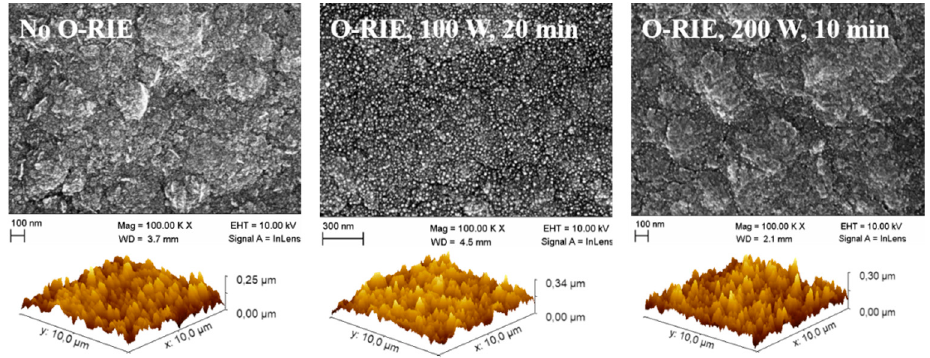
Figure 7. SEM and AFM measurements of sample surfaces, respectively, without O-RIE ( left ), with 100 W O-RIE ( middle ), and 200 W O-RIE ( right ) processes.